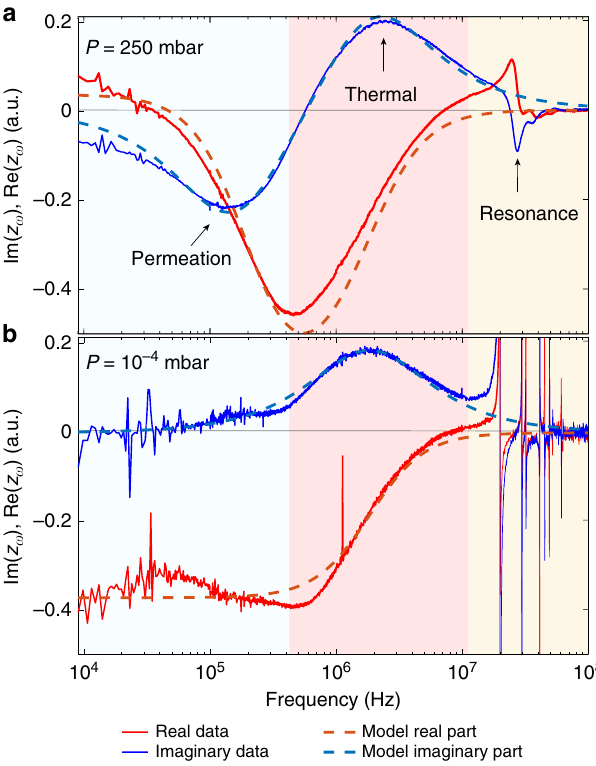
Fig. 2 Graphene membrane motion z ω (phasor) in gas and vacuum. a Frequency response of the micro drum shown in Fig. 1 in nitrogen gas at P = 250 mbar showing the real (in phase, red curve) and imaginary (90 degree phase shift, blue curve) parts of the signal, Im ð z ω Þ , Re ð z ω Þ . Dashed curves indicate the fi tted model response. b Measurement on the same micro drum at P < 10 − 4 mbar shows that the permeation peak diminishes in vacuum and the maximum of the thermal peak shifts by 10% from 2 MHz to 1.8